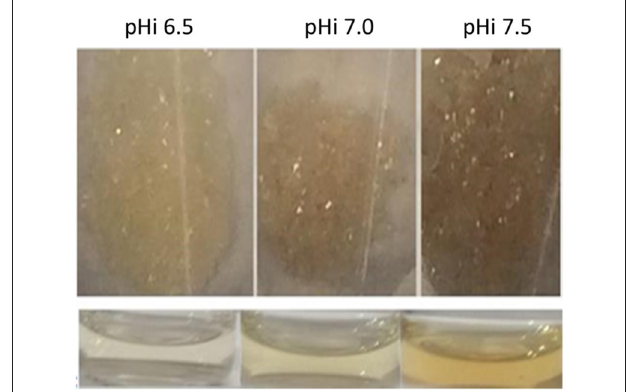
FIGURE 5 | Lyophilized (top) and in solution (bottom) melanoidins fractions with nominal MW from 400 up to 1,800 Da for the three DL prepared at different pH i values.